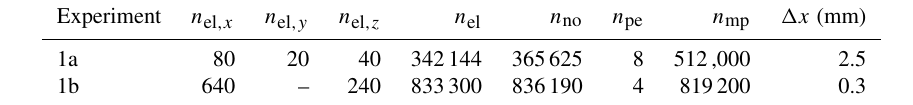
Table 3. Parameters used in Models 1a and 1b for the granular collapse. n el ,i is the number of elements to discretize the granular material in the i th direction, n el and n no are the total number of elements and nodes of the background mesh, n pe is the number of material points per element, and n mp is the total number of material points. Note that the mesh resolution is (cid:49)x = (cid:49)y = (cid:49)z = 2.5mm.